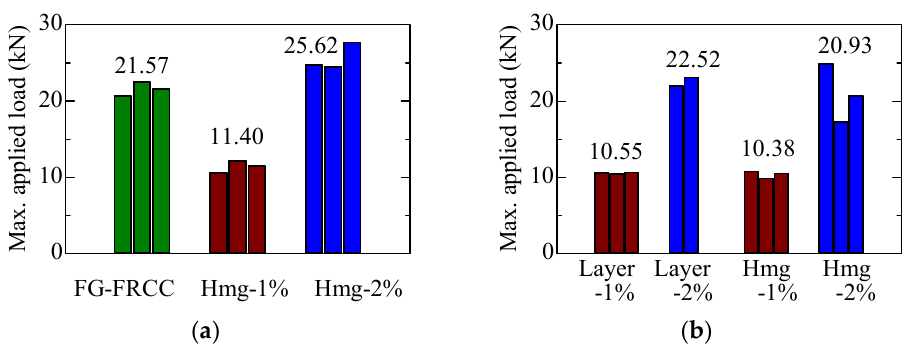
Figure 7. Maximum load comparison: ( a ) 1st day series specimen; ( b ) 2nd day series specimen.